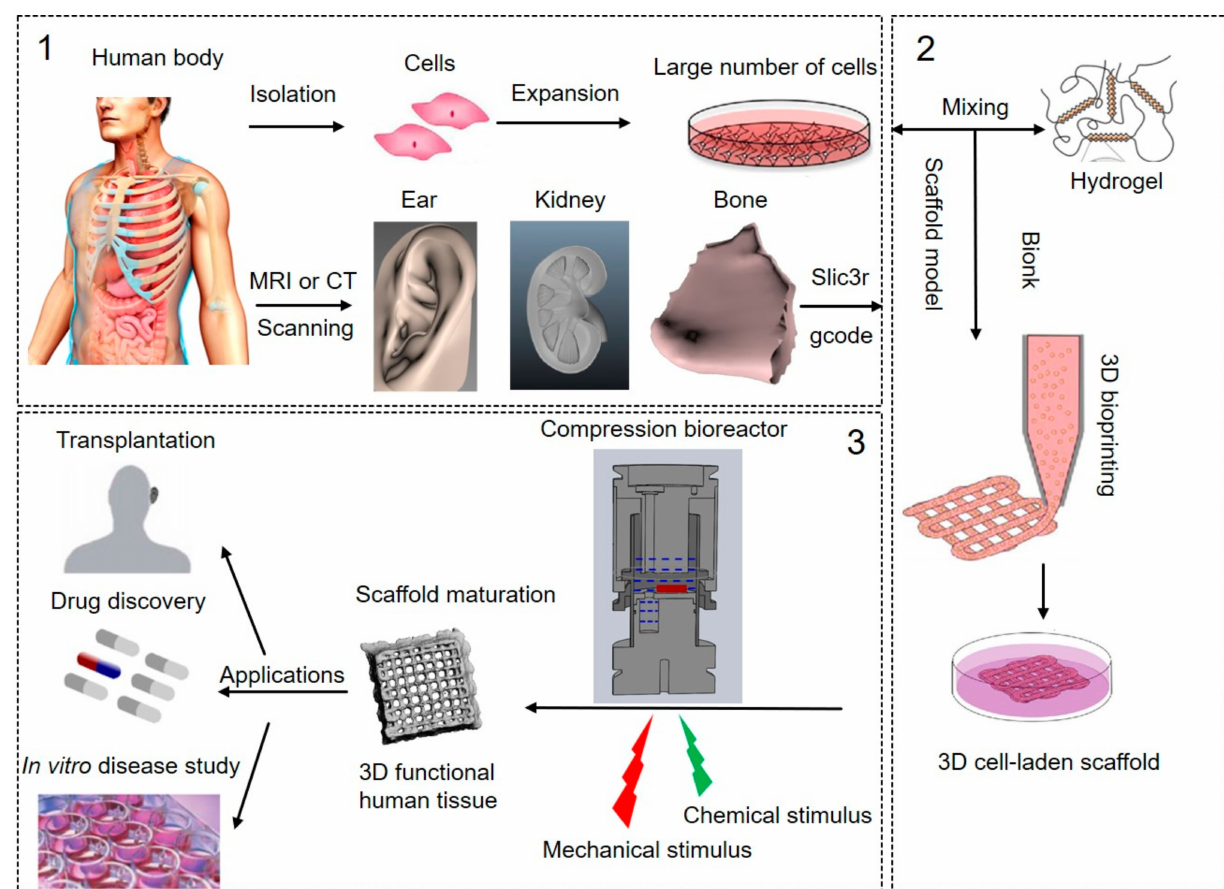
Figure 1. The processes of 3D bioprinting of human tissues. ( 1 ) In pre-processing: isolation of cells from the human body and in vitro cell expansion, Magnetic resonance imaging (MRI) or Computed tomography (CT) scanning were used to achieve the structure information of the target tissue and create the printing model, such as ear, kidney, and bone; ( 2 ) In processing: bioink preparation, 3D bioprinting of 3D cell-laden scaffolds guided by the MRI or CT scanning tissue models; ( 3 ) In post-processing: bioreactor culture system for in vitro scaffold maturation to be 3D functional human tissues, and potential applications of the 3D bioprinted human tissues. Pictures modified with permission from Reference